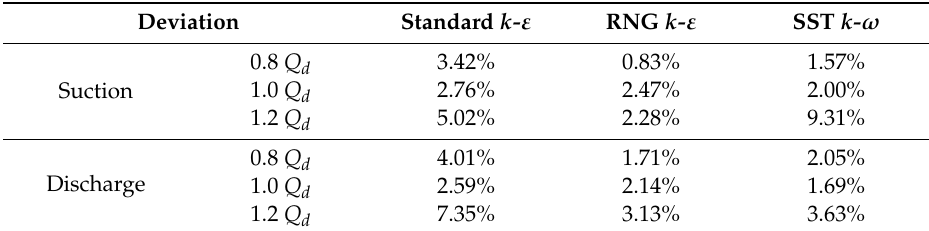
Table 2. Deviation of the sound pressure level L p of the turbulence models and the